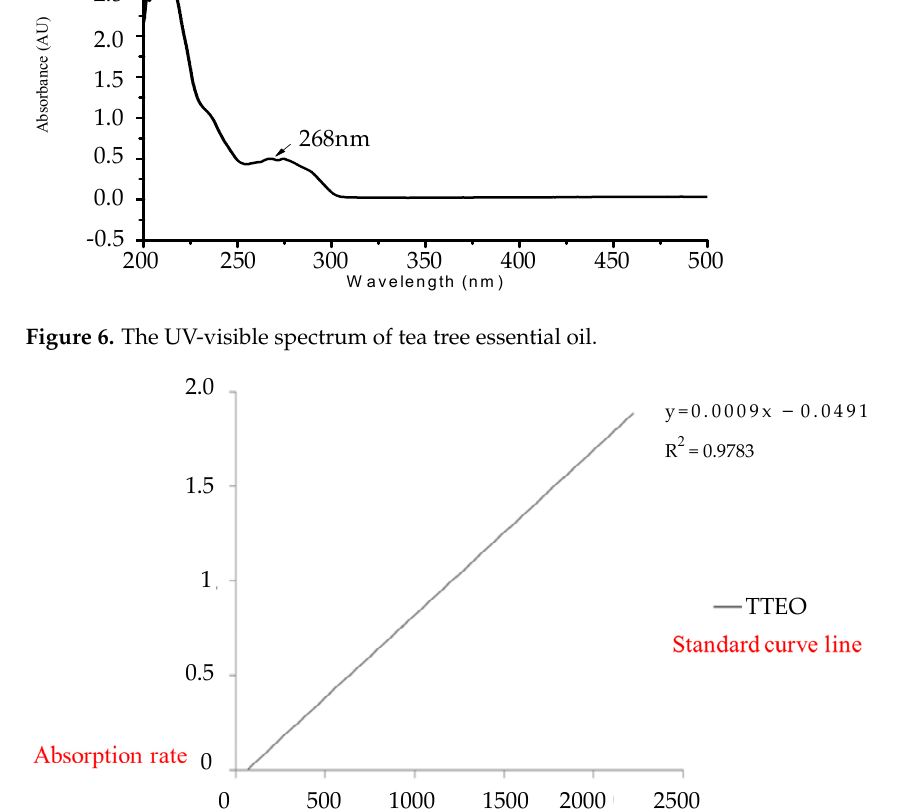
Figure 7. The calibration curve of tea tree essential oil by UV-visible spectroscopy.